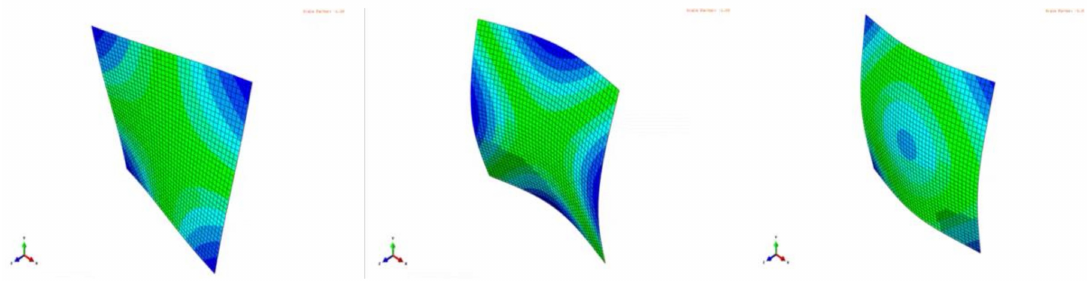
Figure 4. Torsion (left), saddle (middle) and breathing (right) mode shapes of a Poisson